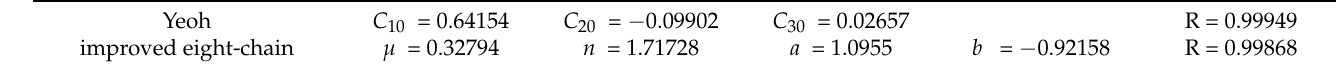
Figure 14. The prediction results of the Yeoh model and the improved eight-chain model for pure shear and biaxial tension according to the fitting parameters of uniaxial tension. Table 6. Constants determined by nonlinear regression